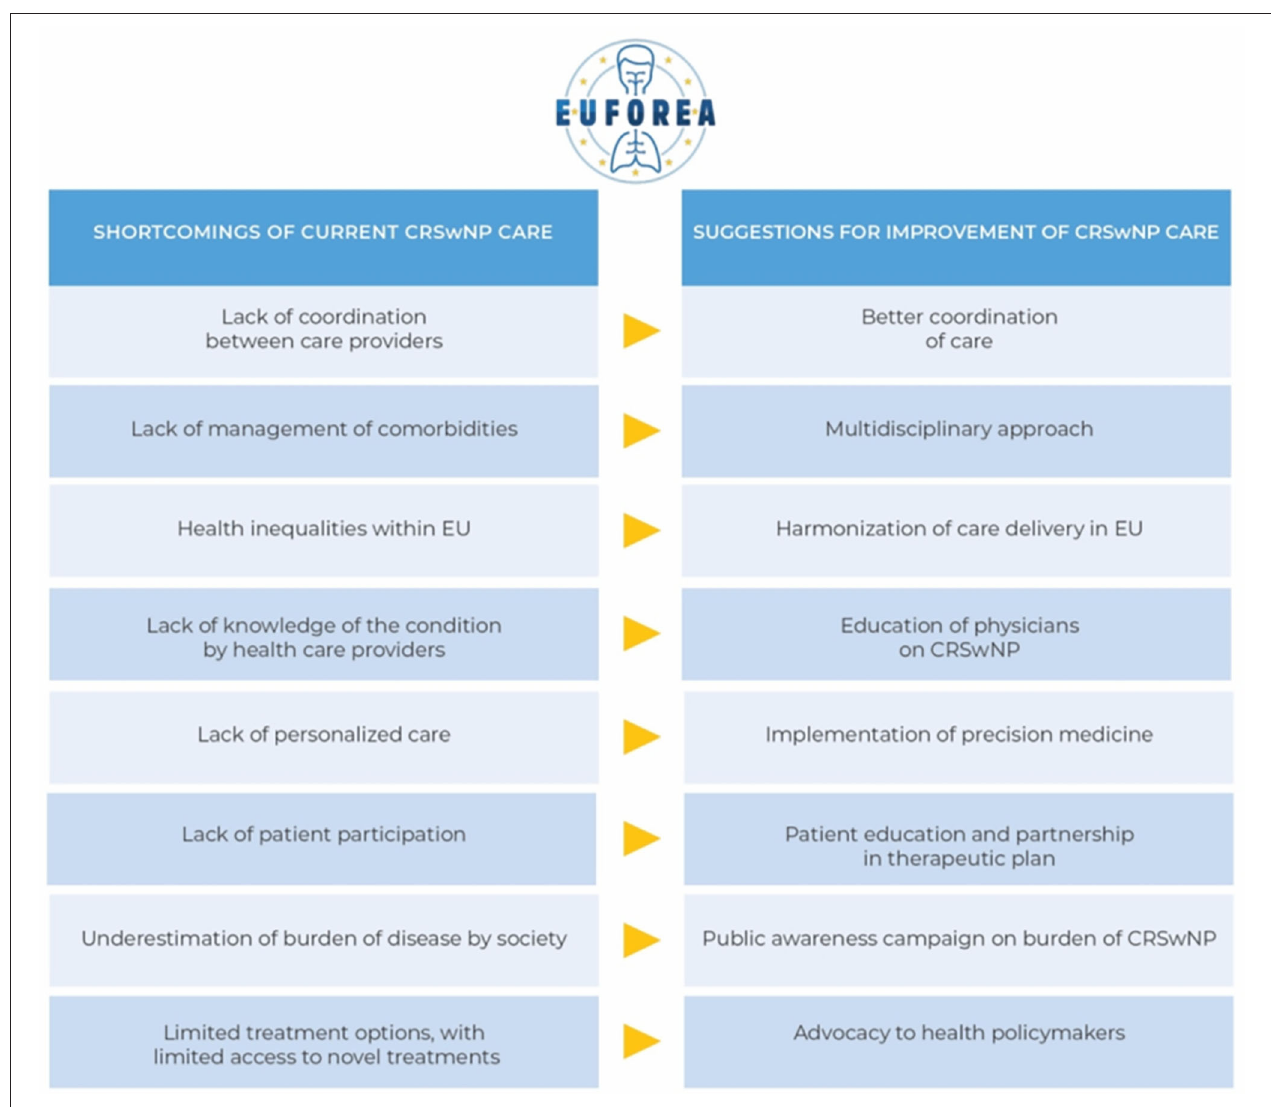
FIGURE 2 | Shortcomings and suggestions for improvement of current care pathways.